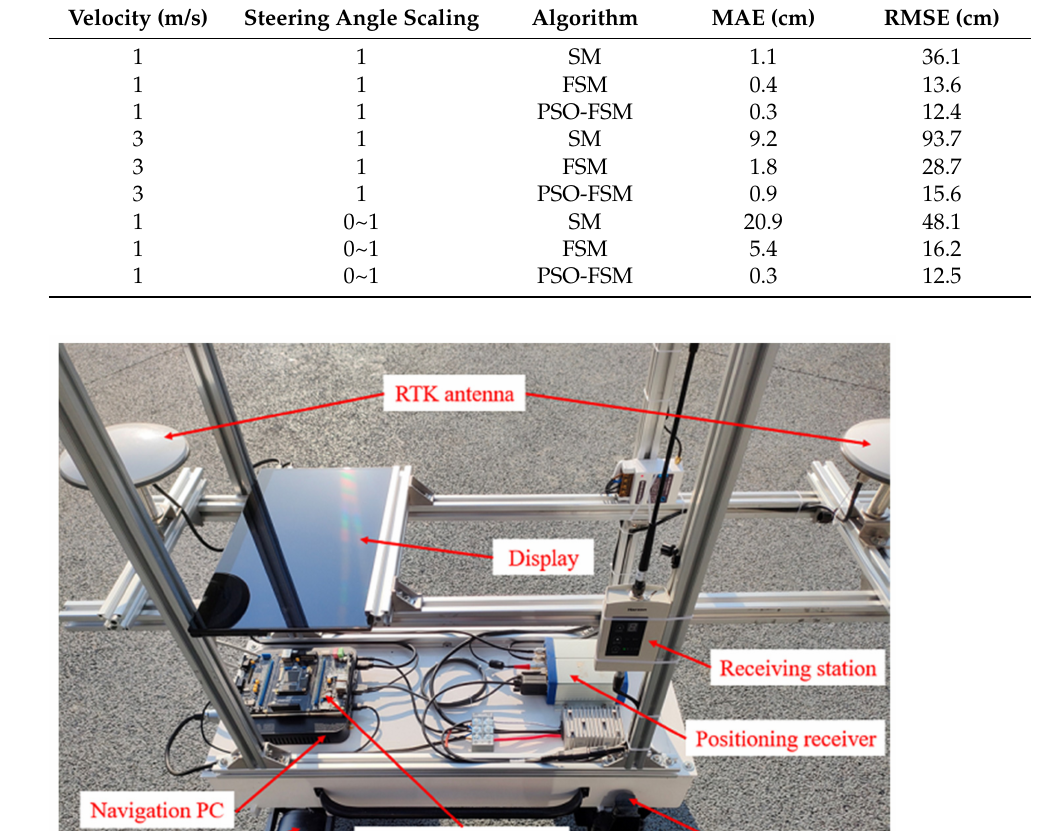
Table 2. Path tracking result under different scenarios.